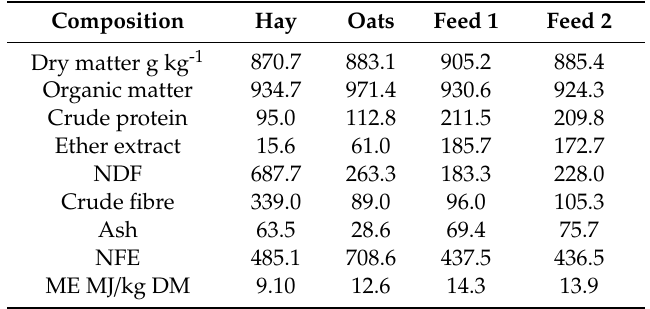
Table 1. Average chemical composition of the experimental feeds (g / kg dry matter). Composition